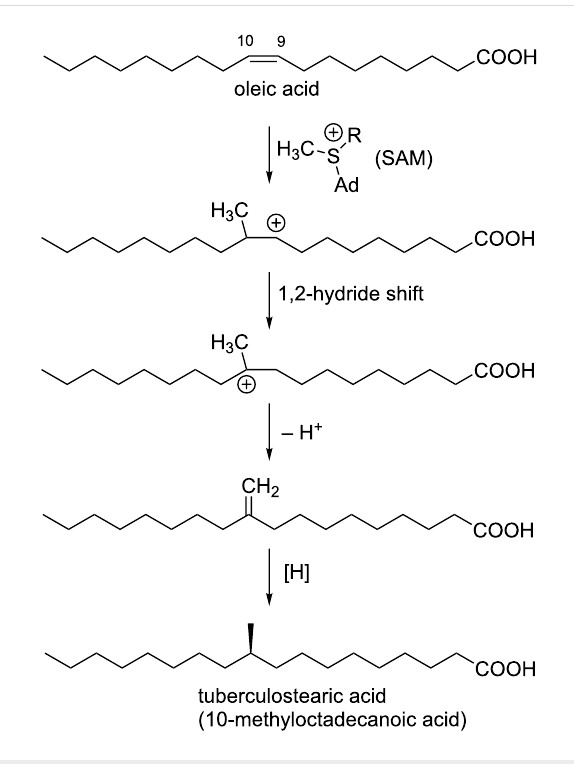
Scheme 2: Biosynthesis of tuberculostearic acid in Mycobacterium .